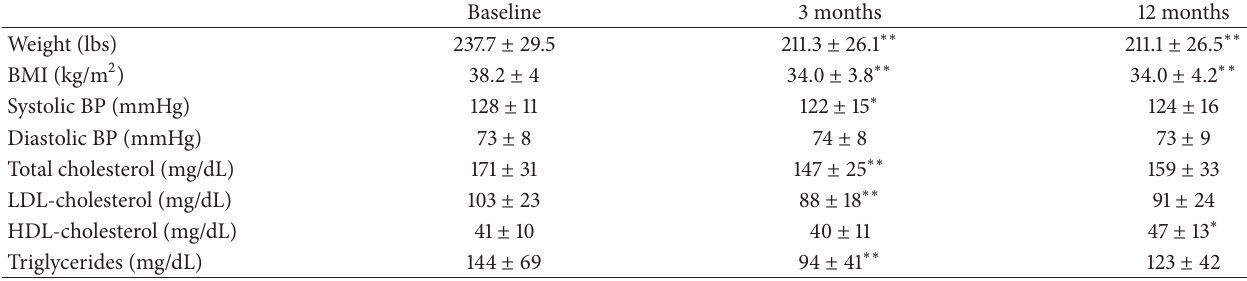
Table 1: Changes in cardiovascular risk factors after 12 weeks of intensive lifestyle intervention and at one year in participants who achieved major glycemic improvement and partial or complete diabetes